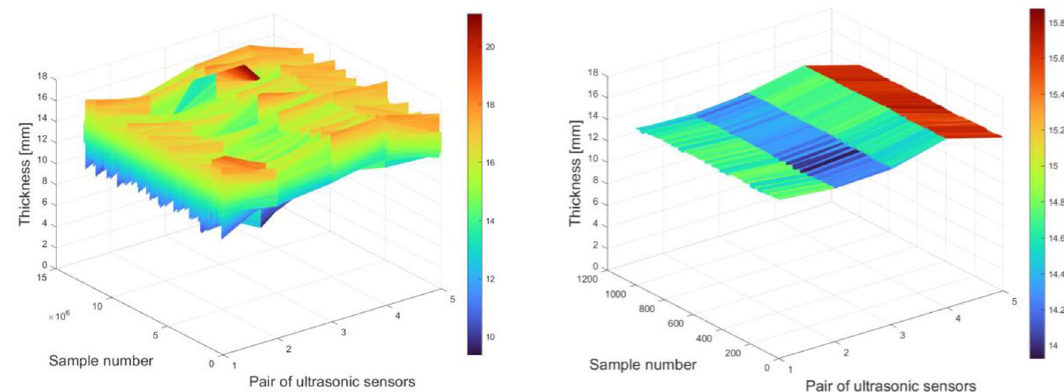
Figure 7. The three-dimensional image of the tape—device prototype testing.